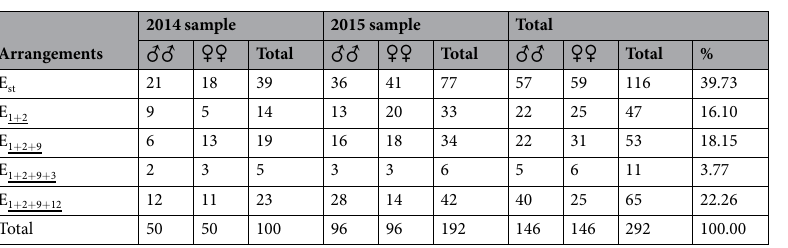
Table 3. Arrangement frequencies in samples from two consecutive